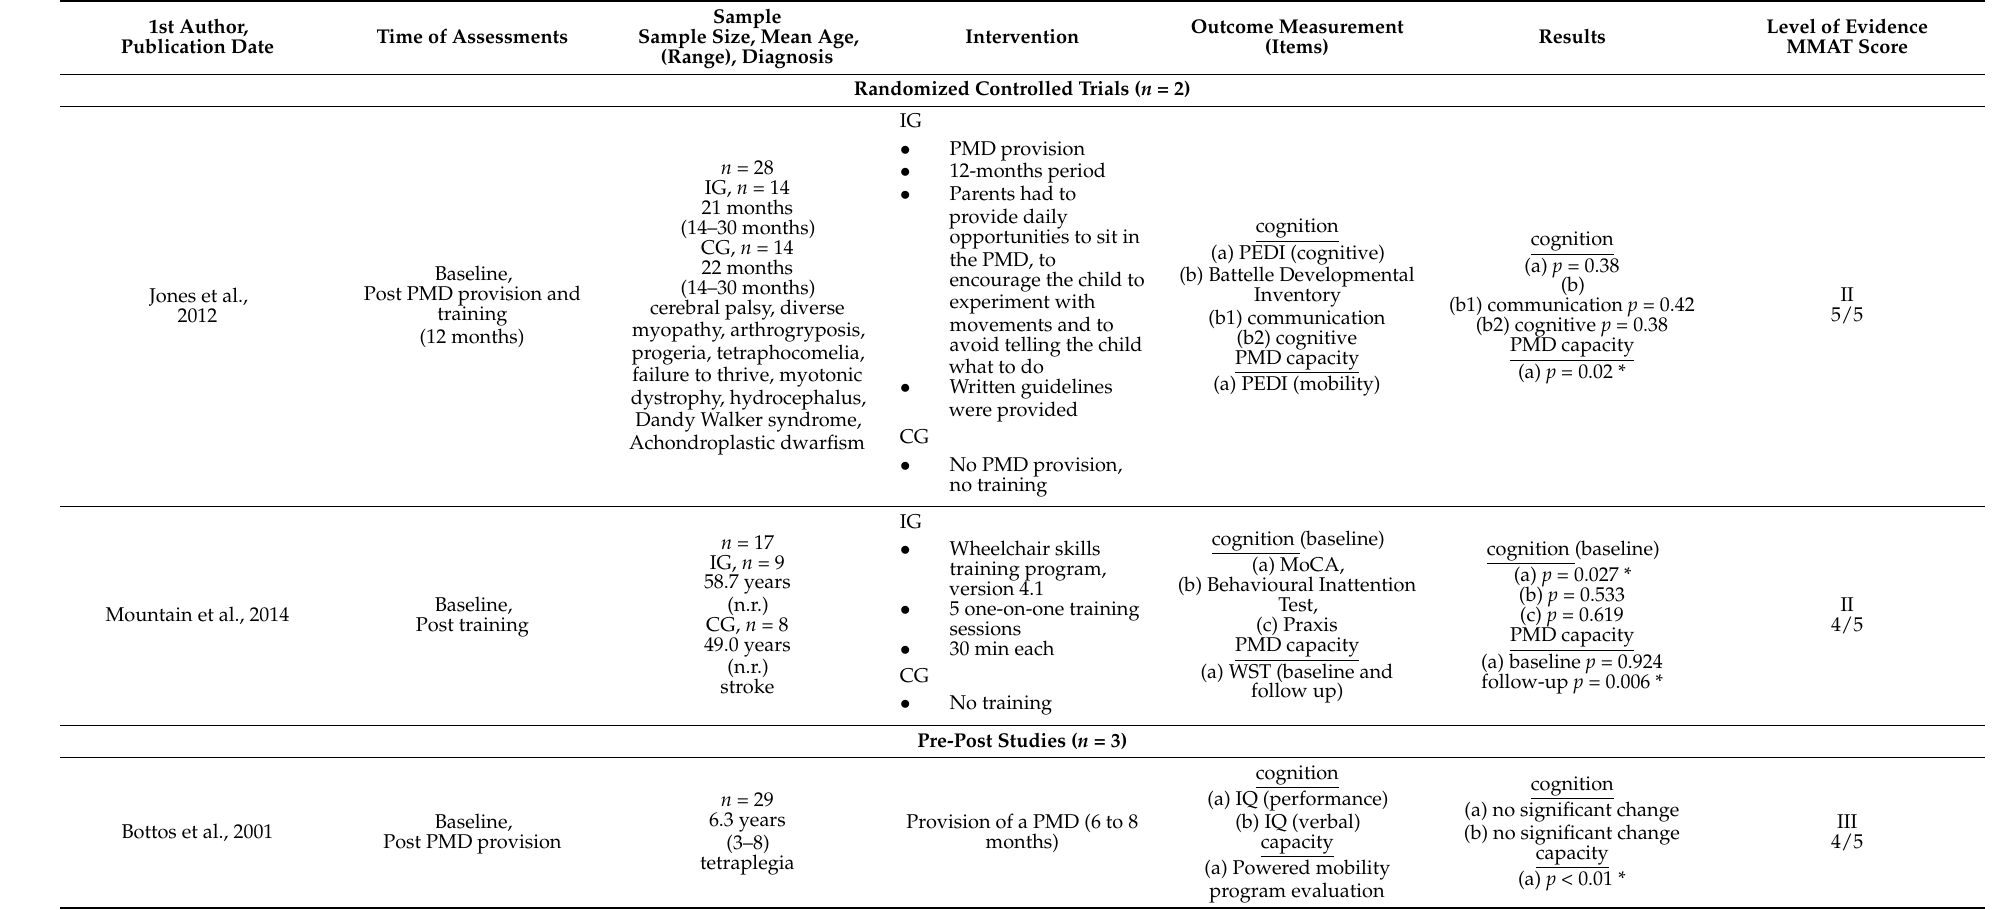
Table 1. Data characteristics, levels of evidence and methodological quality of the studies included ( n =